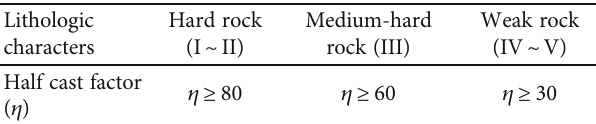
Table 4: Acceptance of presplitting blasting standard according to half cast factor.